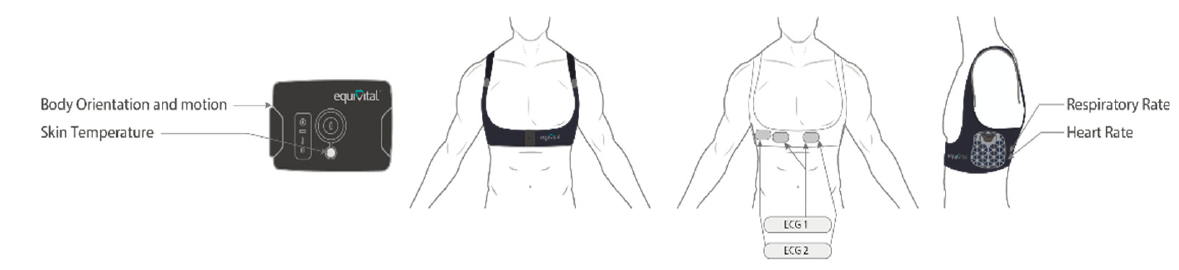
Figure 6. Equivital EQ-02 device (image supplied by Equivital [53]). Figure 5. Equivital EQ-02 device (image supplied by Equivital